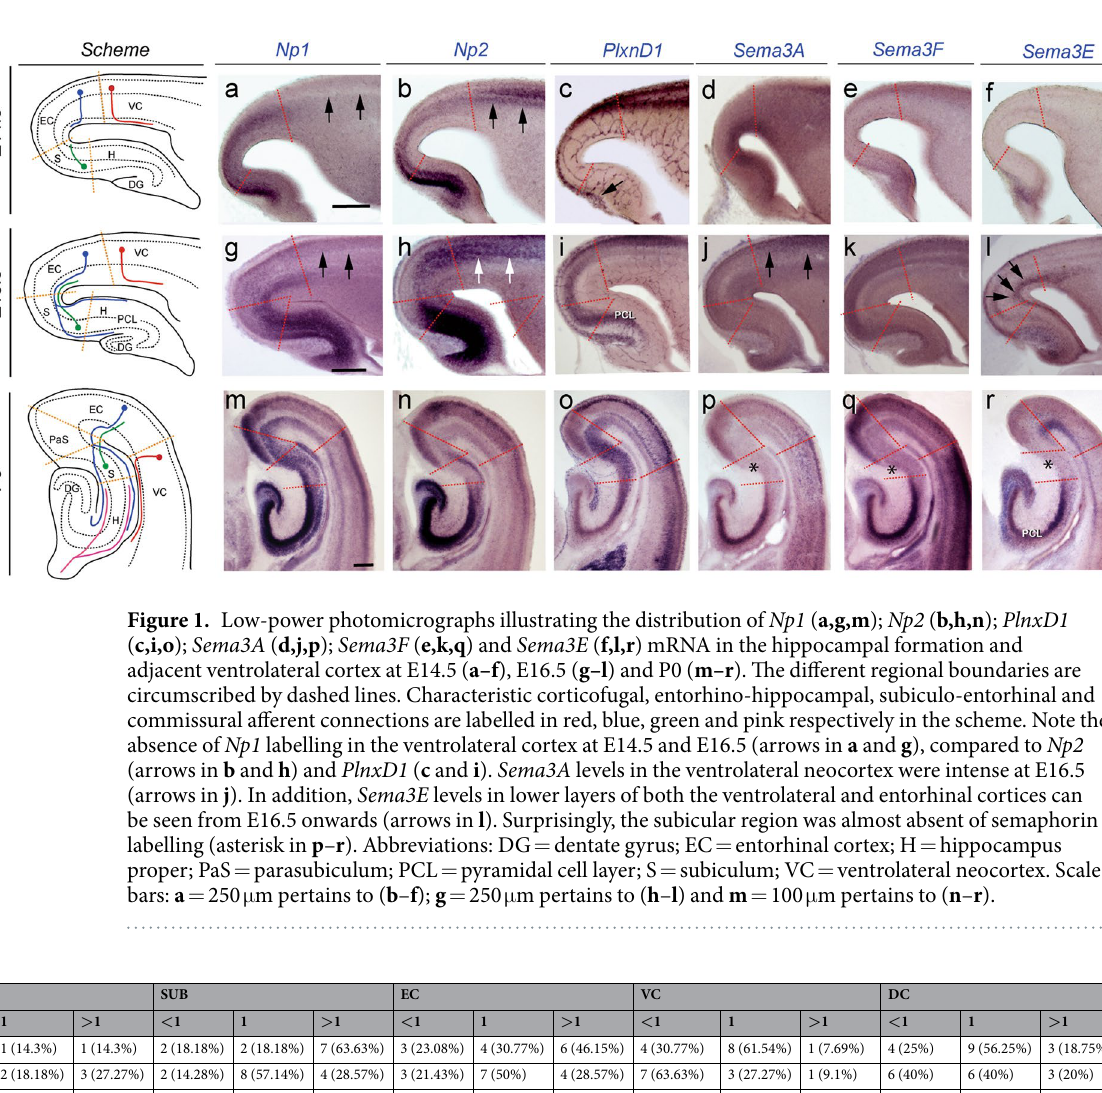
Table 1. Effects of Sema3A, Sema3F and Sema3E on the growth of CA1–3, entorhinal, subicular, ventrolateral and dorsal cortical axons in confrontation experiments (see Material and methods for details). The effects of these class III secreted semaphorins on the experiments are summarized as P/D < 1, P/D = 1 or P/D > 1, indicating chemorepulsion, radial outgrowth or chemoattraction, respectively. For each region the number of cultures displaying these effects is shown. Abbreviations: CA = CA1-3 hippocampal regions; D = distal quadrant; DC = dorsal cortex; EC = entorhinal cortex; P = proximal quadrant; SUB = subiculum; VC = ventrolateral